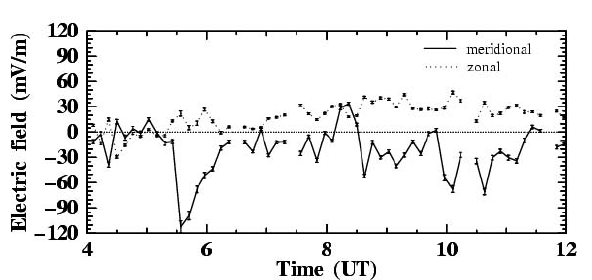
Fig. 4. The derived electric field during 04:00–12:00 UT on March 9, 1999 from the ion velocity at 278km assuming that the E × B force drives motions of ions and electrons. The meridional (solid lines) and zonal (dotted lines) components of the electric field are positive toward the north and east, respectively.